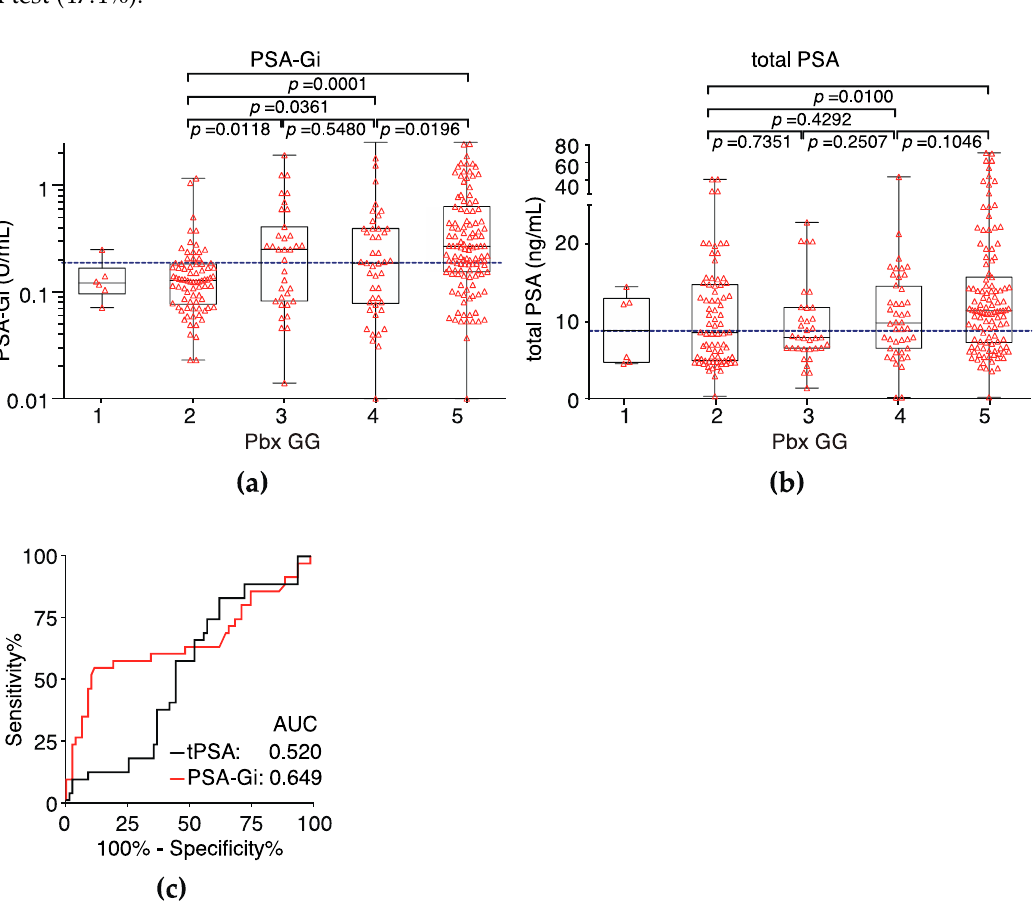
Figure 4. The serum PSA-Gi levels at Pbx in PCa patients who underwent radical prostatectomy (RP). ( a ) PSA-Gi levels before Pbx among PCa patients classified by the Pbx grade group (Pbx GG); ( b ) total PSA level before Pbx of PCa patients classified by the Pbx GG. Cutoff levels at 57.1% sensitivity of PSA-Gi and/or total PSA is presented as a blue dotted line; ( c ) ROC curve analysis of total PSA and PSA-Gi in PCa patients with Pbx GG 2 and Pbx GG 3. The AUCs for the prediction of patients with Pbx GG 3 of PSA-Gi and total PSA were 0.649 and 0.520, respectively.